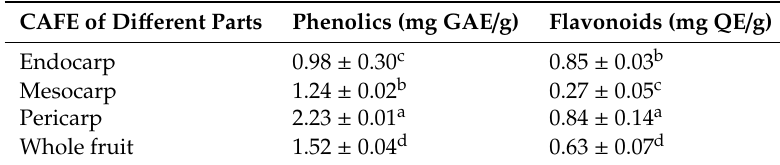
Table 1. Total phenolic and flavonoids content in endocarp, mesocarp, pericarp, and whole from cactus acid fruit